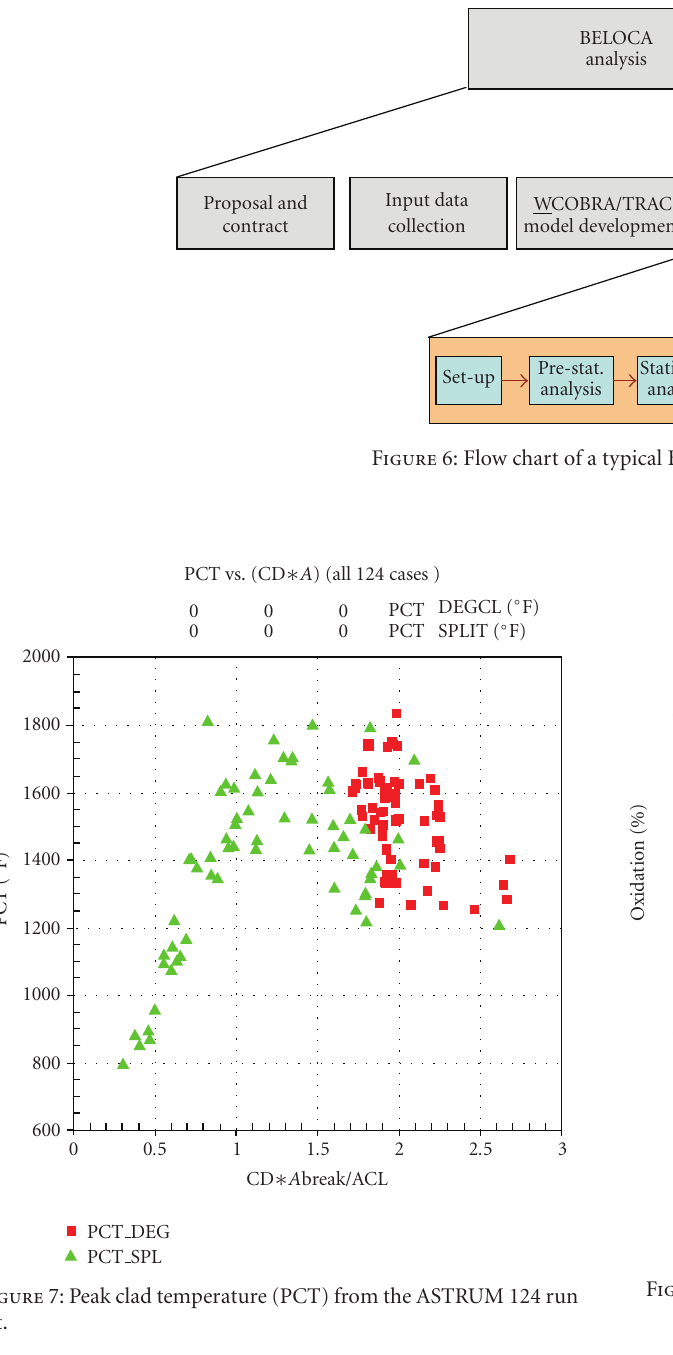
ment on three main ECCS design criteria (10 CFR 50.46) is acceptable by the